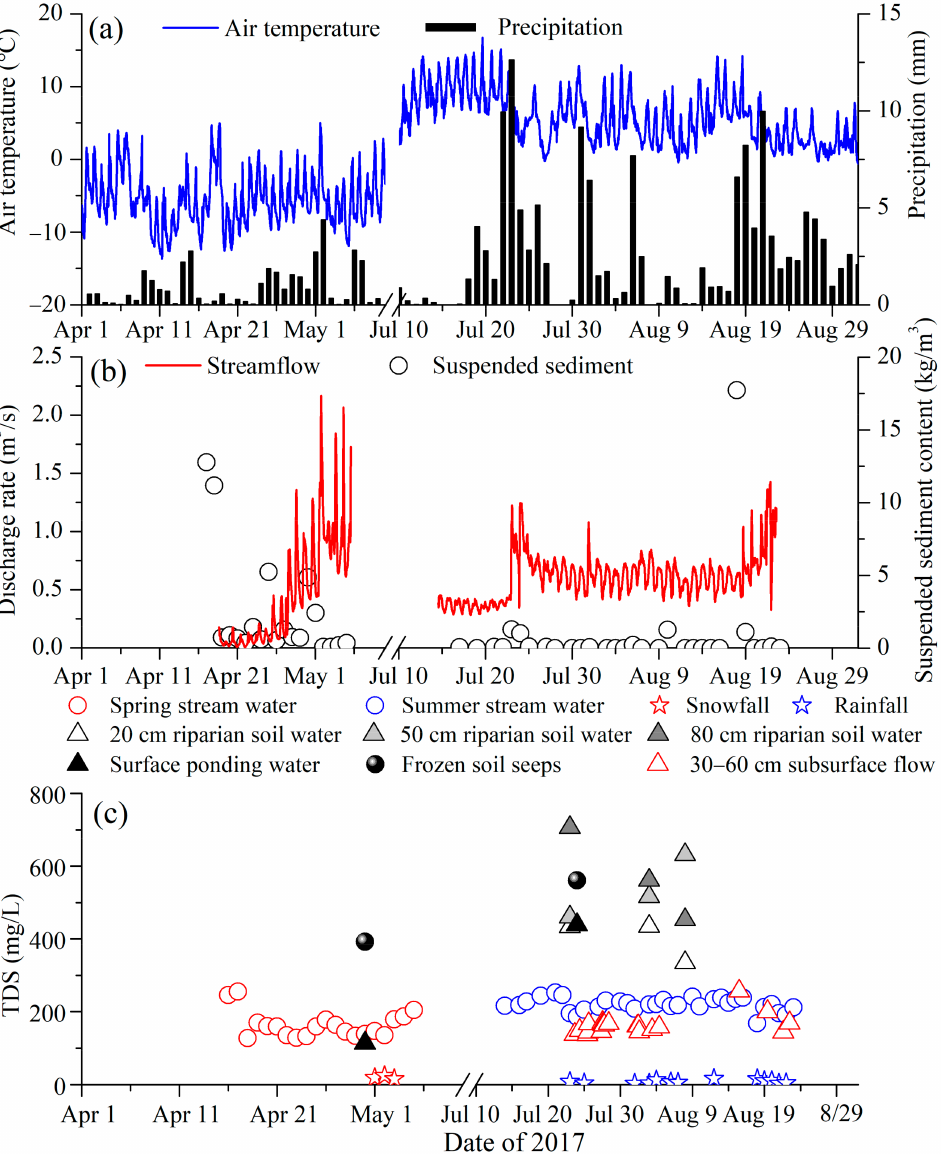
Figure 4. Time series of air temperature and precipitation at the automatic weather station ( a ), streamflow discharge and suspended sediment content at the outlet of the Binggou catchment ( b ), and total dissolved solids (TDS) of different water types ( c